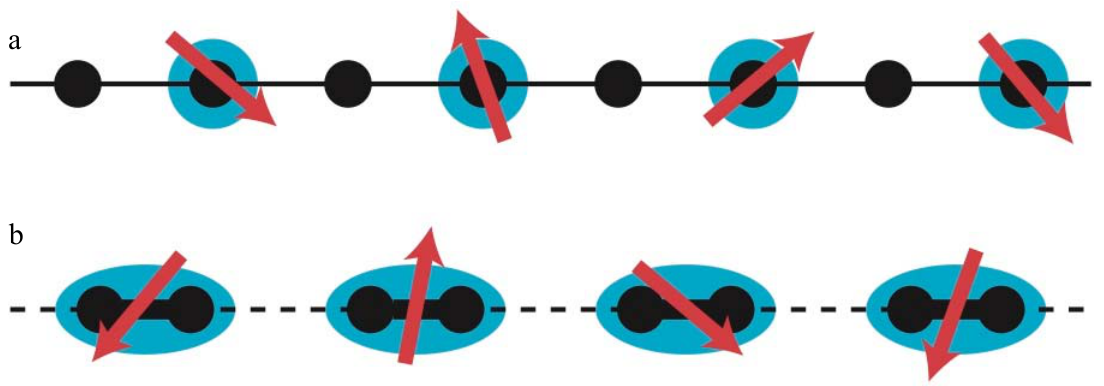
Figure 2. Two limiting cases of 1/4-filled bands: ( a ) Charge ordered states in the absence of dimerization; ( b ) Mott insulators in the presence of strong